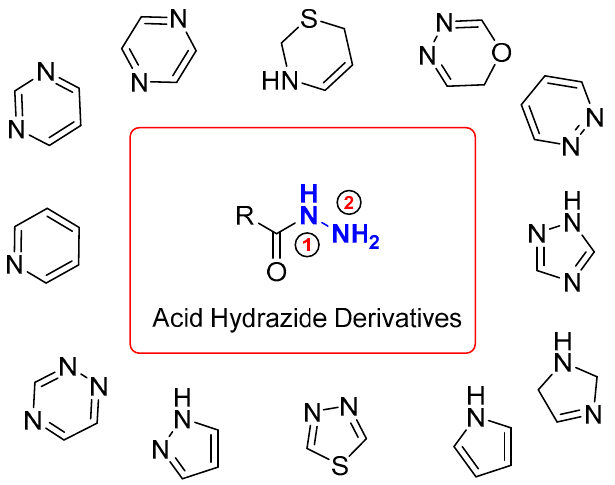
Figure 4. Heterocycles derived from acid hydrazide reported in the literature [8].